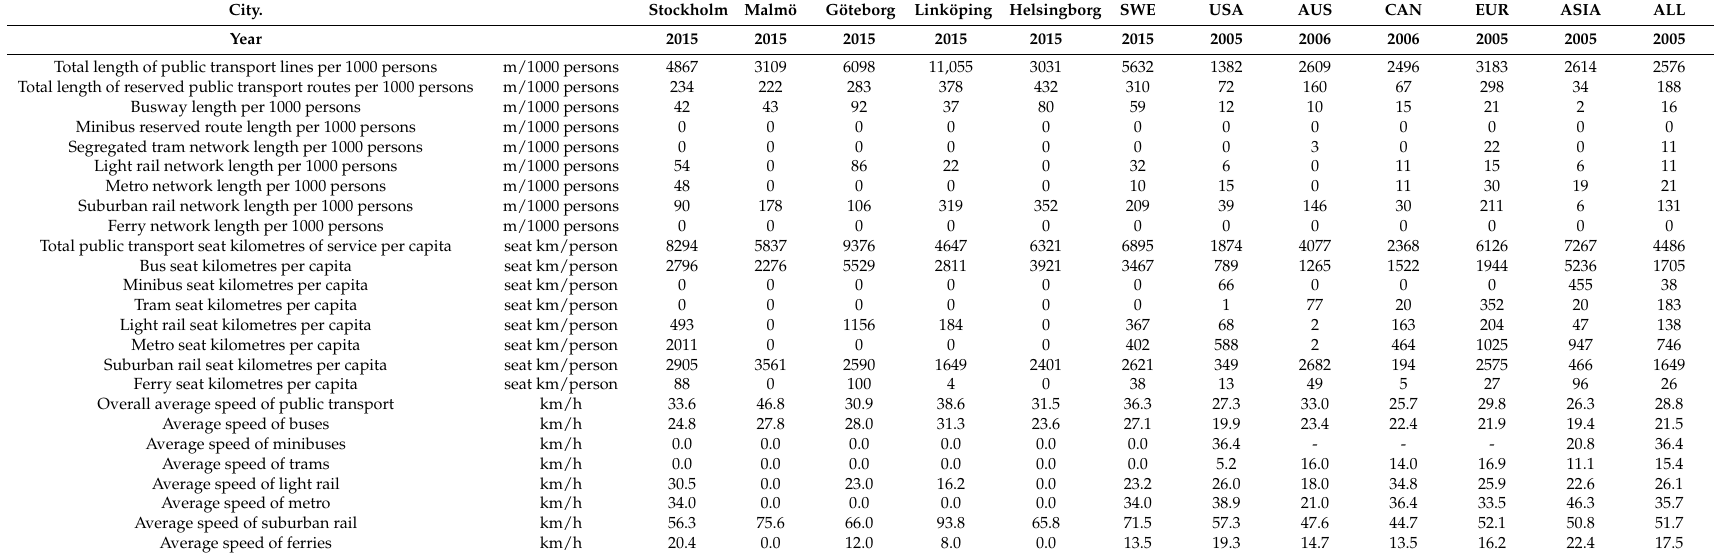
Table 5. Public transport infrastructure and service characteristics of Swedish and international cities.